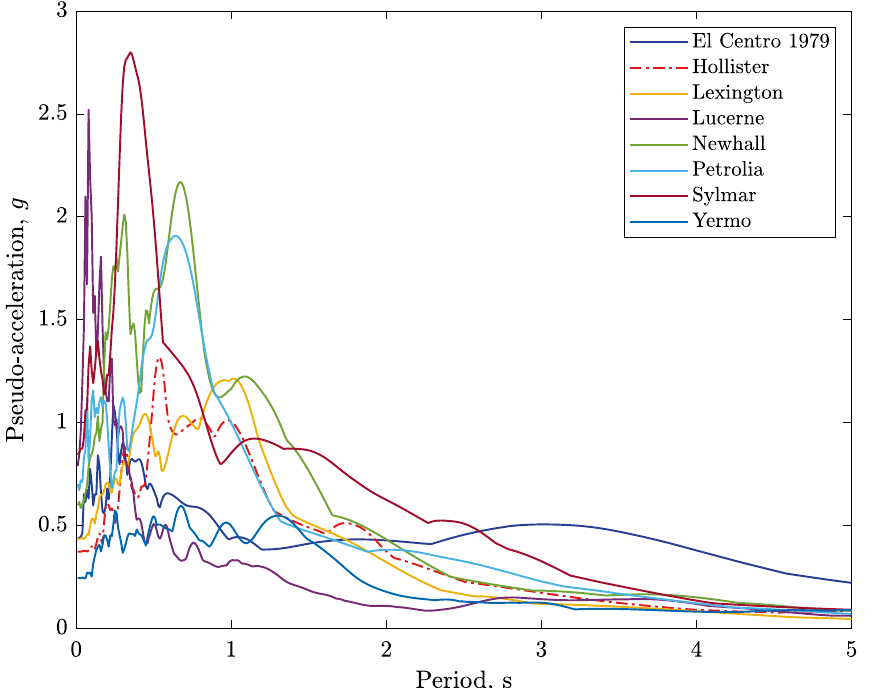
Figure 13. Pseudo-acceleration response spectra for the CDMG suite of earthquakes, ζ = 5% .